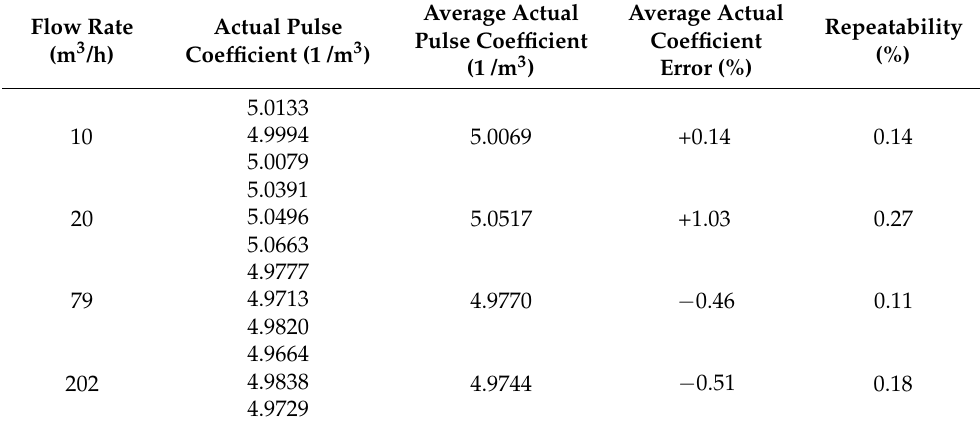
Table 2. Calibration